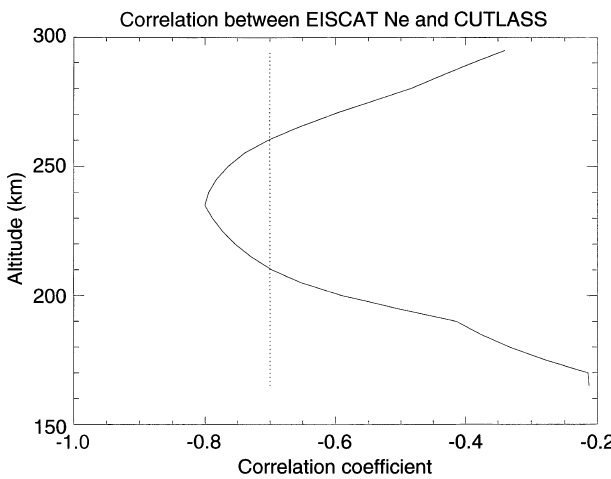
Fig. 9. Correlation coe(cid:129)cient between CUTLASS first range returns and the EISCAT electron density at a range of altitudes, assuming a delay of 108 s for the CUTLASS data